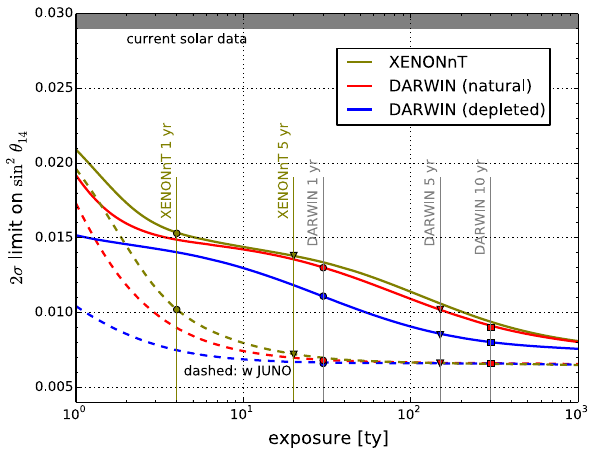
Fig. 7 Sensitivity to sin 2 θ 14 at 2 σ ( (cid:4)χ 2 = 4) from low-energy elas- tic neutrino-electron scattering in XENONnT and DARWIN as a func- tion of the exposure, combined with current solar neutrino data (solid curves). For dashed curves we assume in addition that sin 2 θ 12 is deter- minedwithaprecisionof0.67%(1 σ )byJUNO.ForDARWINweshow in red the results for natural abundance of 136 Xe, whereas blue curves assume depletion by two orders of magnitude. The grey shaded area indicates the region excluded by current solar neutrino data. Vertical lines indicate exposure times of 1, 5, and 10 years, assuming a fiducial mass of 4 t for XENONnT and 30 t for DARWIN